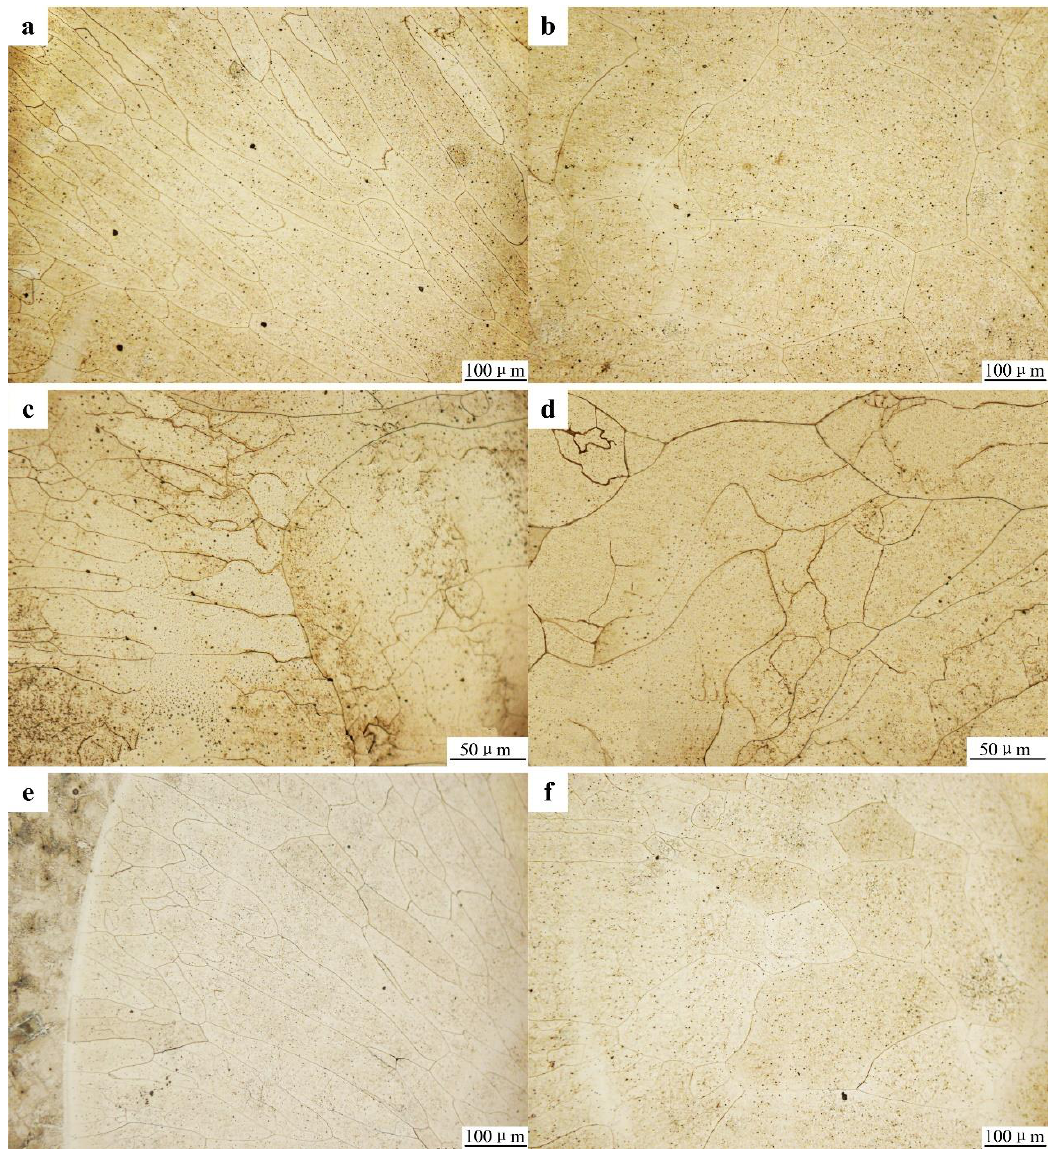
Figure 6. Microstructures of specimens I ( a , b : CC 0.2 m/min), II ( c , d : CC 0.3 m/min), and III ( e , f : PC 0.2 m/min).